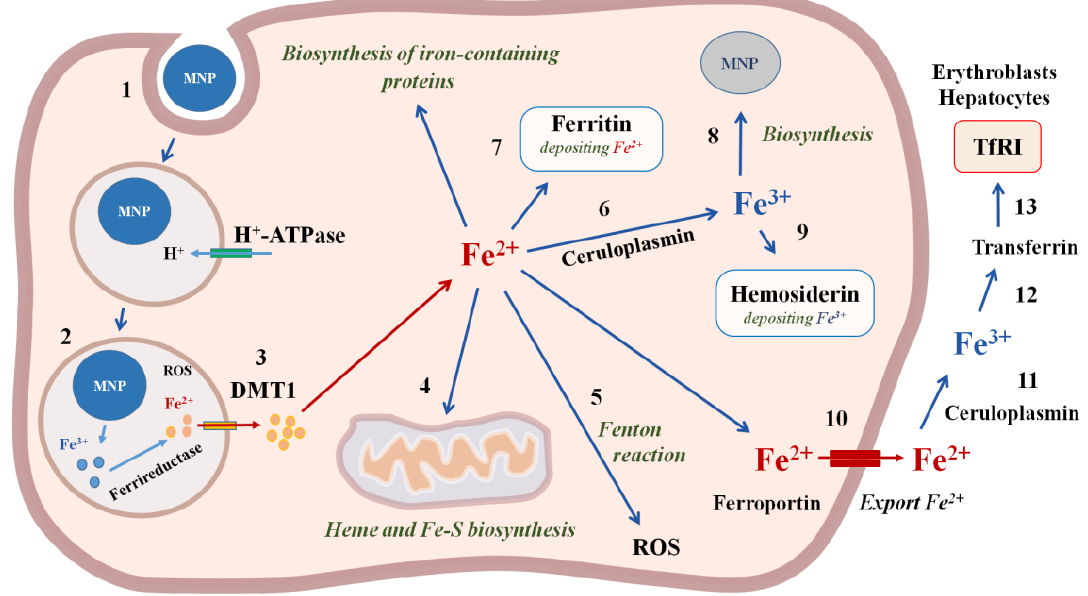
Figure 4. The mechanisms of iron magnetic nanoparticles incorporation and biodegradation in the cell. 1—MNP incorporation using endocytosis; 2—degradation of MNP and reduction in iron with ferrireductase; 3—Fe 2+ transfer through the membrane with divalent metal transporter DMT1; 4— transport of Fe 2+ into mitochondria for heme and Fe-S biosynthesis; 5—ROS formation in the Fenton reaction; 6—oxidation of Fe 2+ with ceruloplasmin to Fe 3+ ; 7—deposition of Fe 2+ with ferritin; 8— biosinthesis of cellular MNPs; 9—deposition of Fe 3+ with hemosiderin; 10—export of Fe 2+ from the cell with ferroportin; 11—oxidation of Fe 2+ with ceruloplasmin to Fe 3+ ; 12—binding to transferrin; 13— Transferrin entry into the cells, which contain Transferrin receptors TfR1on the cell membranes, in particular, erythroblasts and hepatocytes.